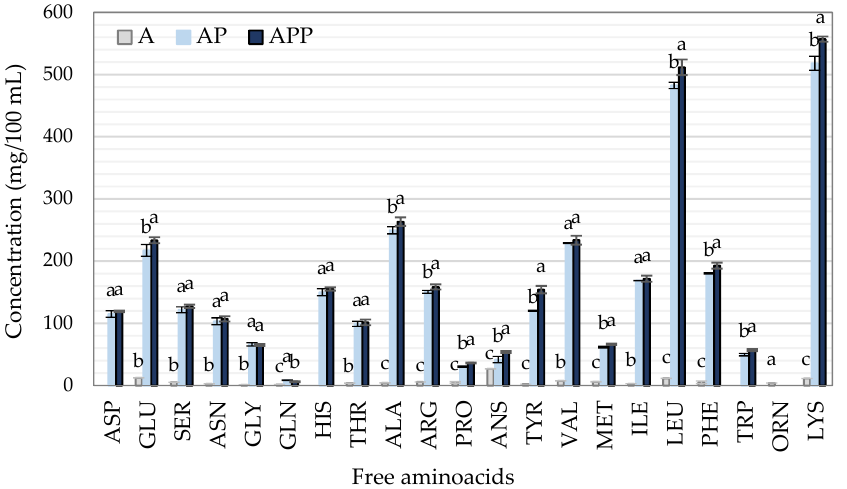
Figure 4. Concentration of free amino acids in three different hydrolysates: A (2% Alcalase), AP (2% Alcalase + 5% Protana Prime) and APP (2% Alcalase + 5% Protana Prime + 3% Protana UBoost). Bars with the same letter between samples are not statistically different. Tukey, p < 0.05.